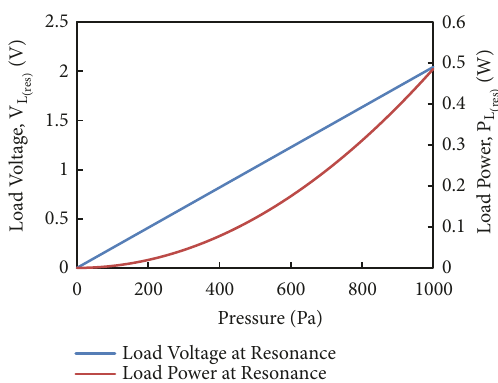
Figure 10: Load voltage generated by the simulated energy har- vester.